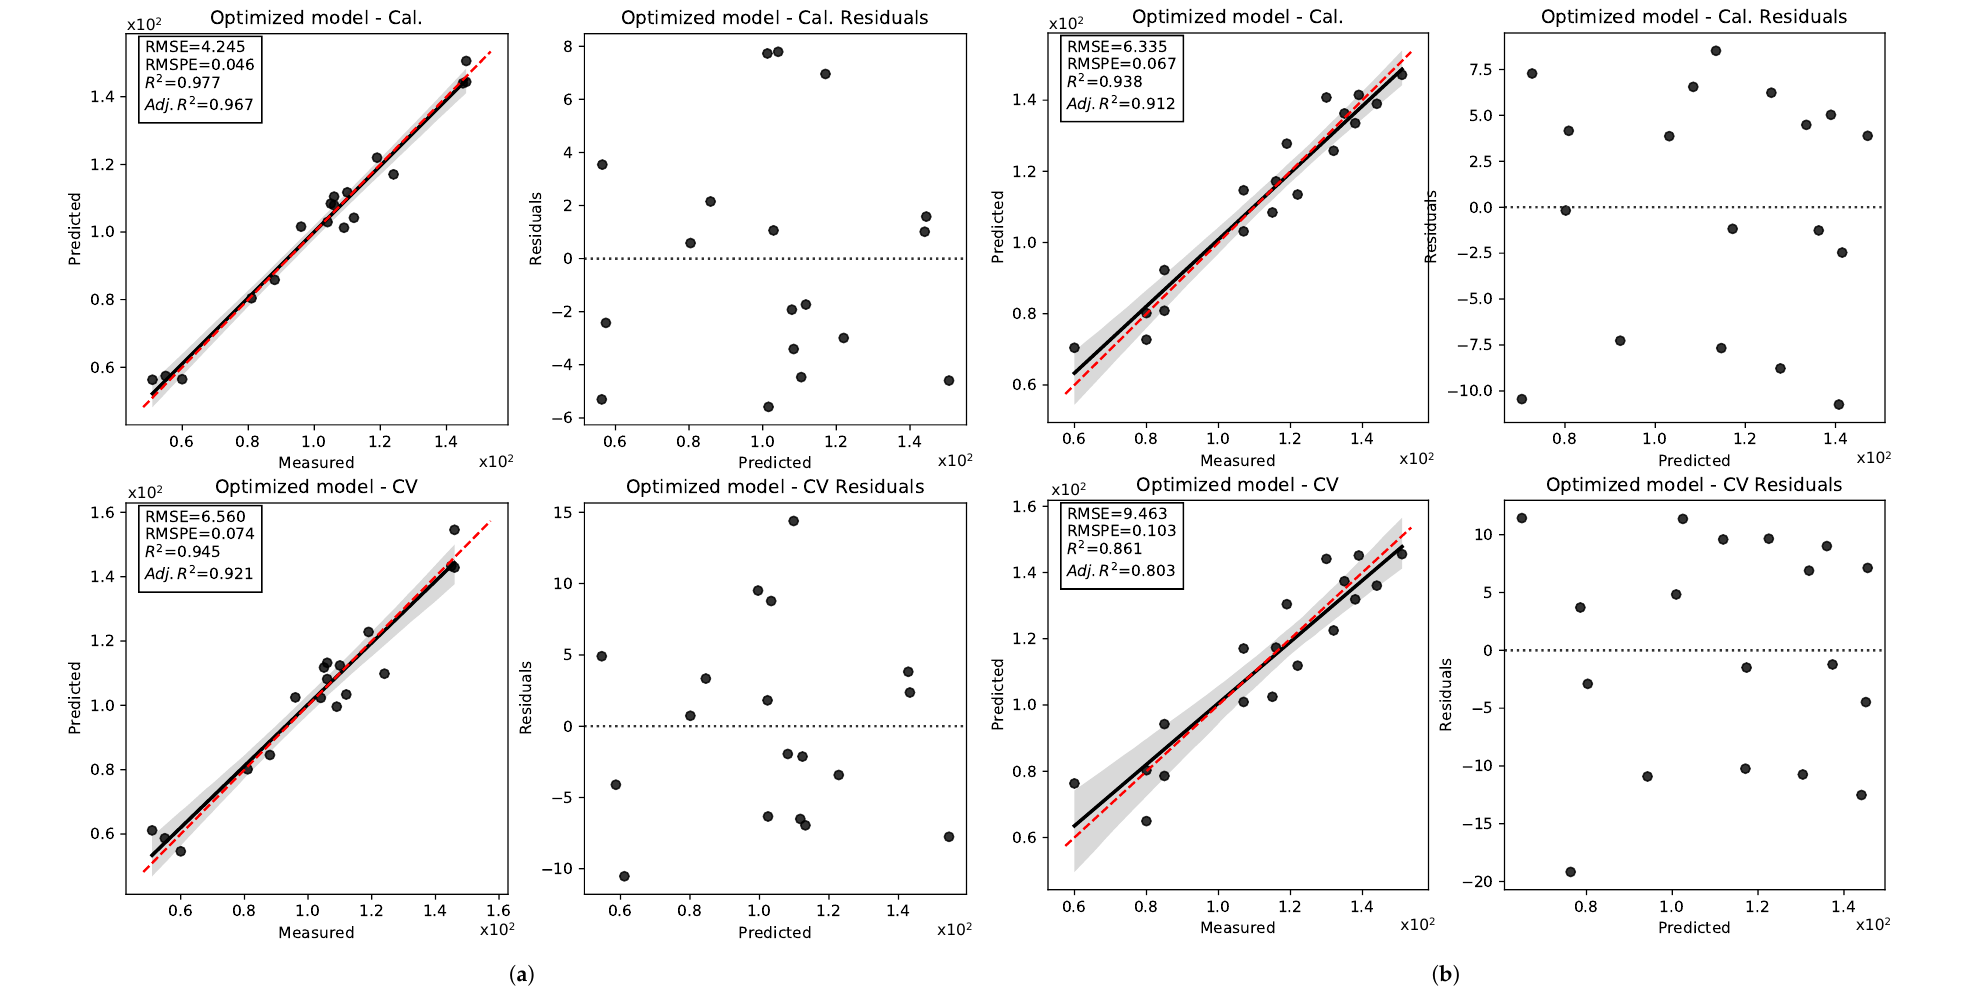
Figure 19. Regression results for snap bean 2020 seed length data set on ( a ) SA-SAM model at 58 DAP for the early harvest stage and ( b ) ACO-SAM model at 58 DAP for the late harvest